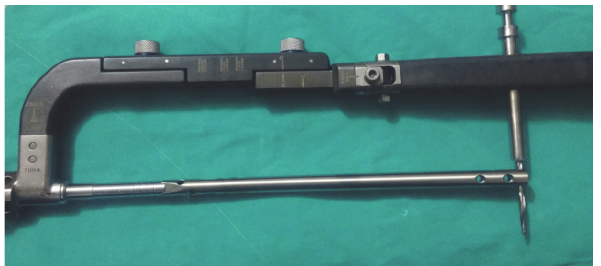
Figure 2: Distal guide.